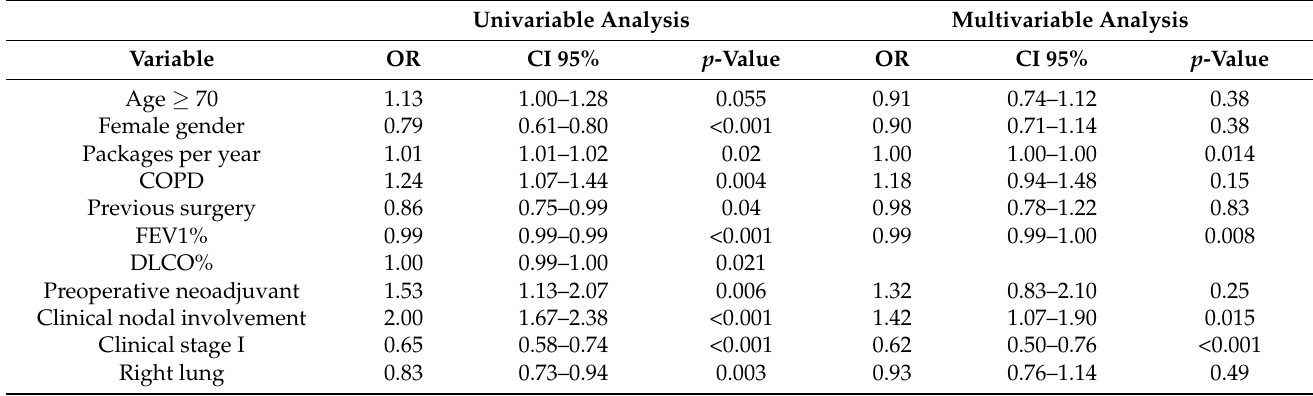
Table S2. Blood transfusion ( (cid:36) = 0.099, p < 0.001) showed the largest correlation with conversion, according to the Spearman correlation test (Supplemental Table S3).